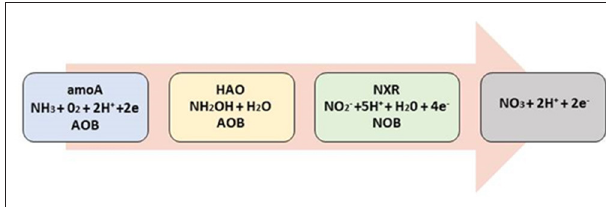
FIGURE 2 | Schematic diagram showing biochemical reaction in nitrifying bacteria.